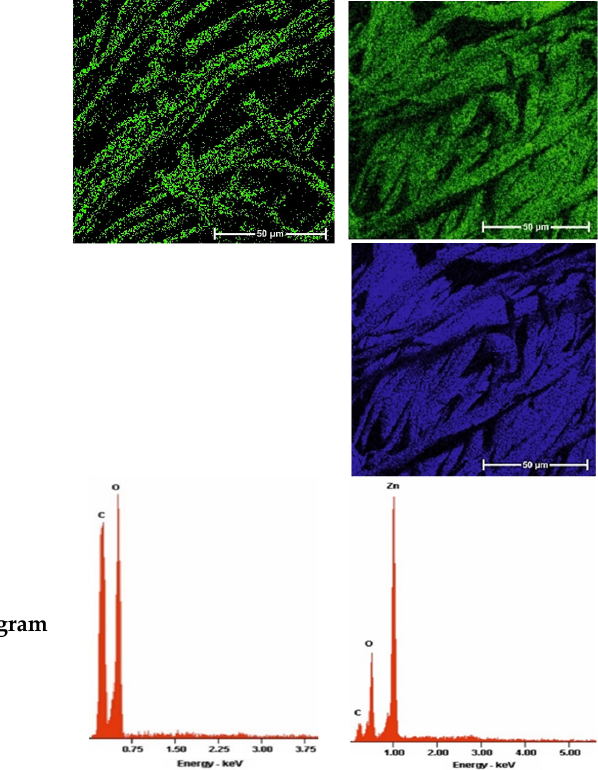
Figure 2. Multi-element EDS mapping images and EDS spot analysis diagram: analysis of the chemical composition of COT and COT–Zn sample.